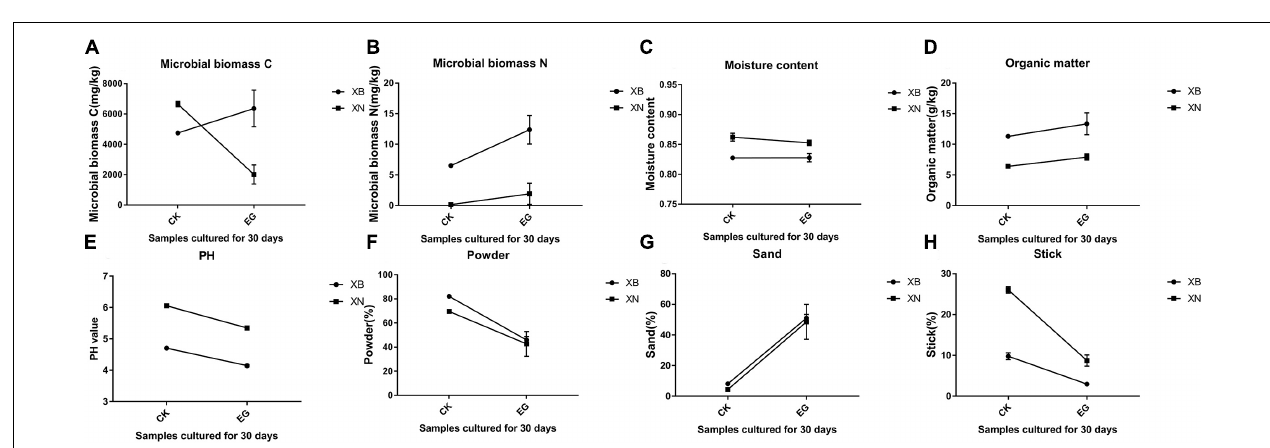
FIGURE 8 | Colony and micromorphological features of four fungal isolate at 400x magnification.